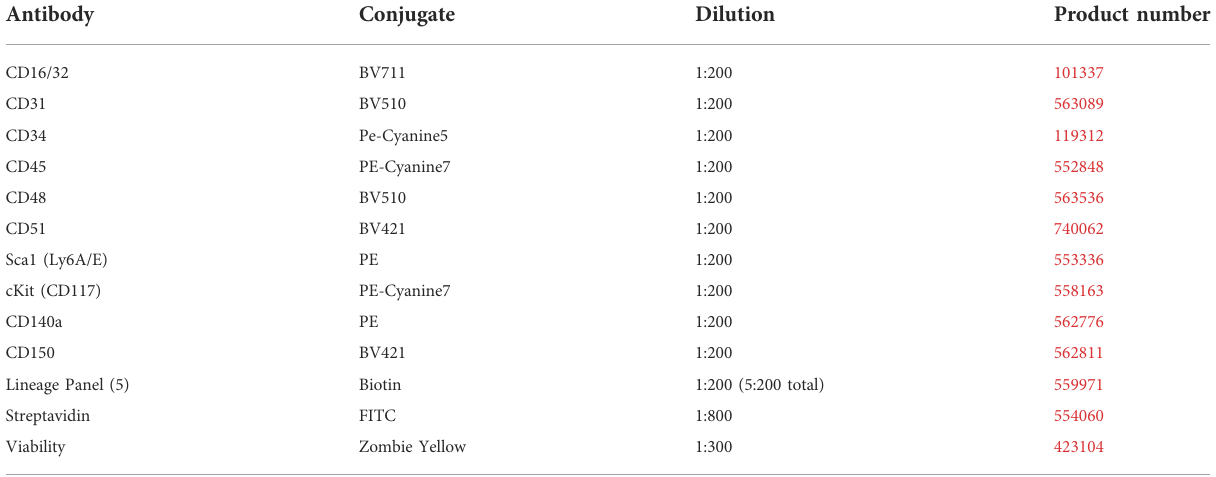
TABLE 2 Antibodies used for fl ow